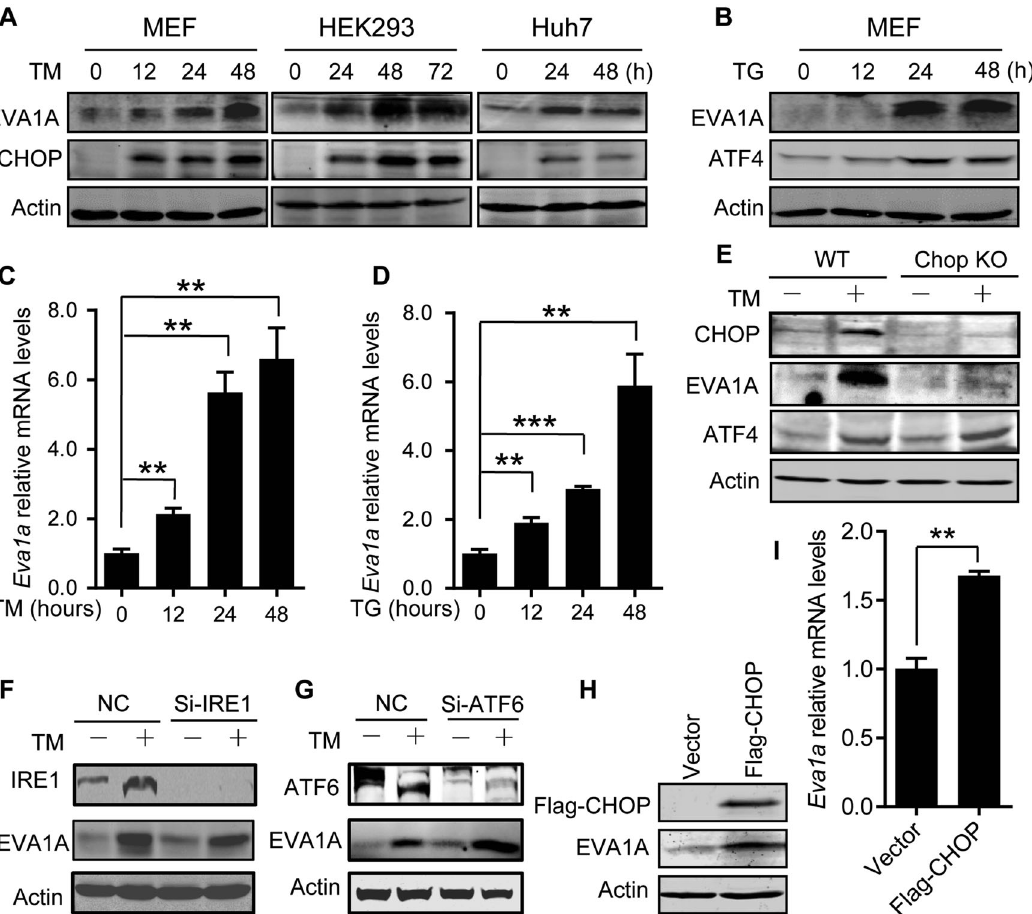
Fig. 1 ER stress promotes EVA1A expression via CHOP. A Western blot analysis of CHOP and EVA1A protein levels at indicated time points in cells treated with 3 μ g/ml Tunicamycin (TM). B Western blot analysis of ATF4 and EVA1A protein levels at indicated time points in MEF cells treated with 0.2 μ M Thapsigargin (TG). C , D Relative mRNA level of EVA1A in MEF cells treated with TM ( C ) or TG ( D ) at indicated time points ( n = 3). E The protein level of EVA1A in WT and Chop KO MEF cells treated without or with 3 μ g/ml TM for 36 h. F, G The protein level of EVA1A in IRE1 knockdown ( F ) or ATF6 knockdown ( G ) MEF cells treated without or with 3 μ g/ml TM for 36 h. H Western blot analysis of the EVA1A protein level in Flag-CHOP overexpressing HEK293 cells. I The relative mRNA levels of EVA1A in HEK293 cells overexpressing Flag-CHOP ( n = 3). Data are presented as mean ± SD, (** p < 0.01, and *** p <